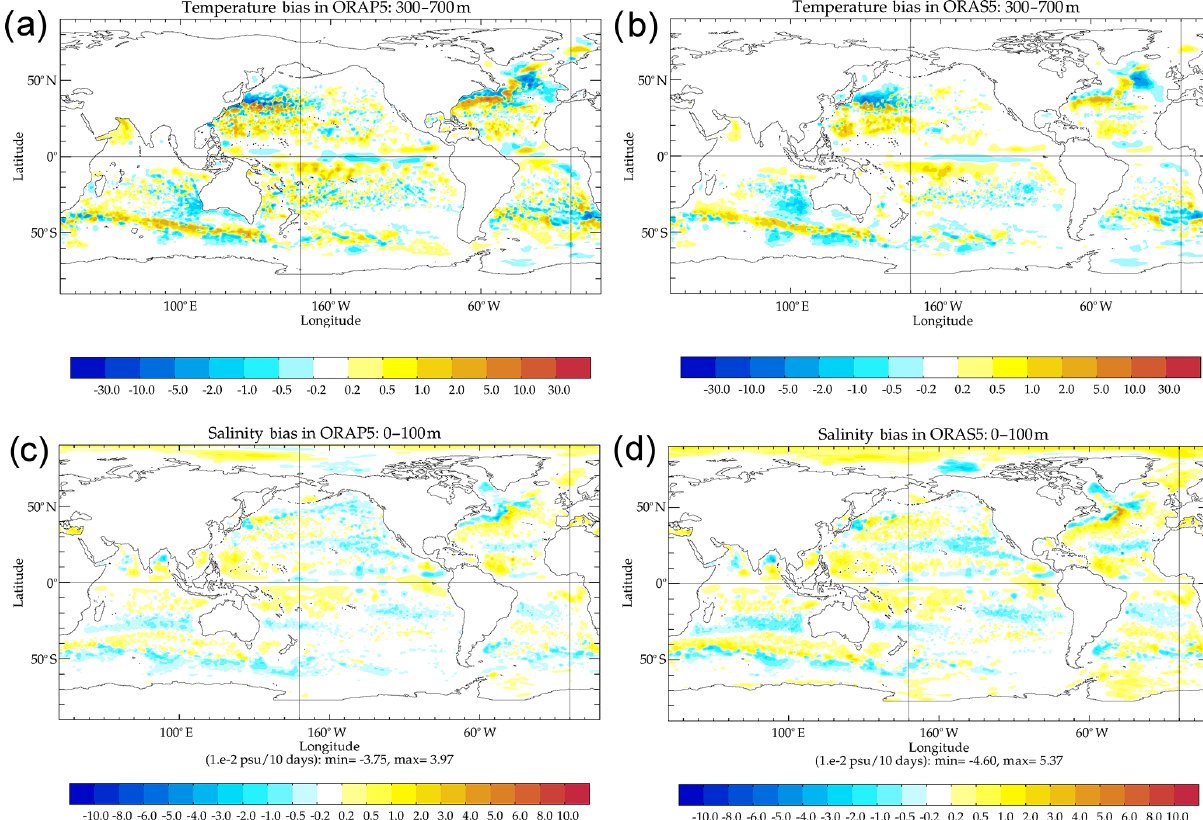
Figure 10. Maps of the annual mean a priori bias correction term applied to (a, c) ORAP5 and (b, d) ORAS5 as (a, b) temperature (units are 0.01K per 10d) and (c, d) salinity (units are 0.01psu per 10d). The reader should note that temperature bias is averaged over 300–700m and salinity bias is averaged over